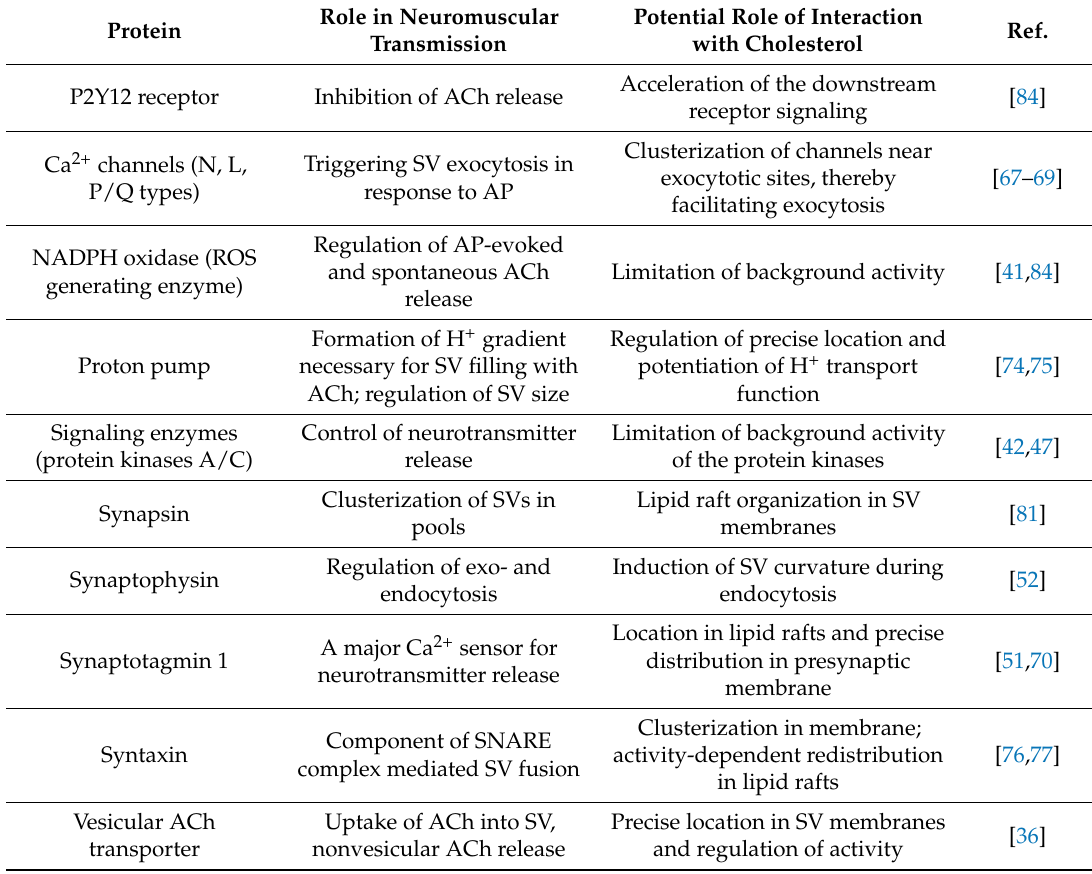
Table 1. Some potential interactions between cholesterol and proteins involved in regulation of neurotransmitter release from motor nerve terminals. Role in Protein